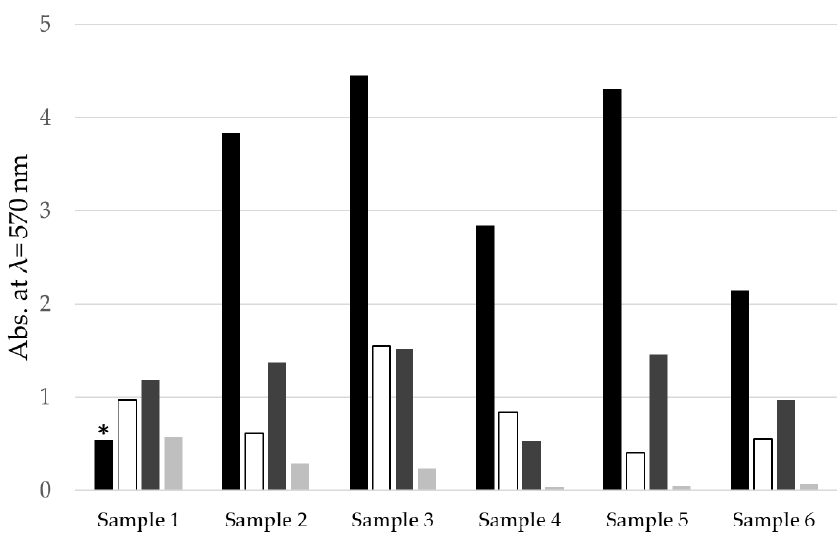
Figure 7. Quantitative analysis of biofilm formation at the Ti-Zr disc surface at different stages. Black: Control/no treatment/positive, white: curette/chlorhexidine, dark gray: 2.5 min DDE treatment, gray: 5 min DDE treatment, *: biofilm detached during washing step.